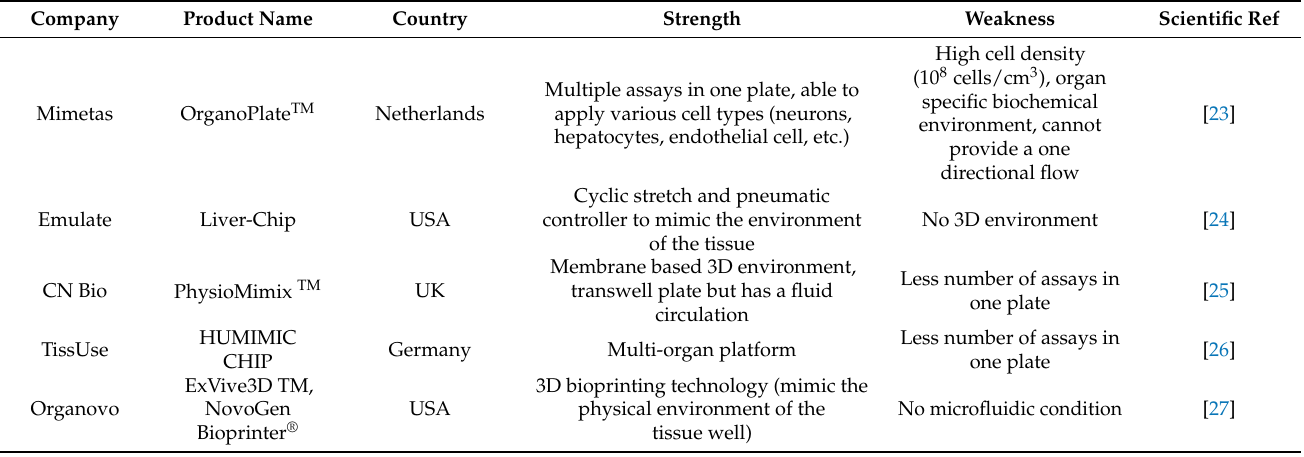
Table 1. Summary of the companies that provide in vitro models and their technical production methods with strengths and weaknesses.